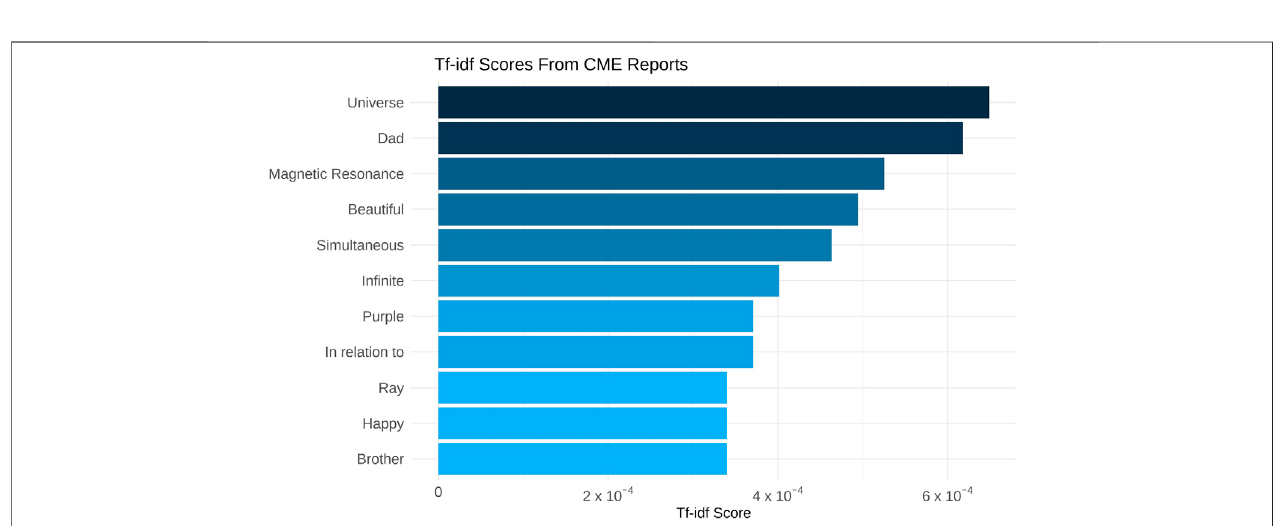
FIGURE3| ResultsofthelatentvariablemodeldescribingtheestimateofeffectoftheMEQtotalandsubscale scoresmeasured onthedayofpsilocybinonPPE LV measured 3 months after psilocybin. The y -axis represents each individual subscale while the x -axis provides an estimate of the difference in PPE LV associated with a one-unit increase in the indicated MEQ subscale.